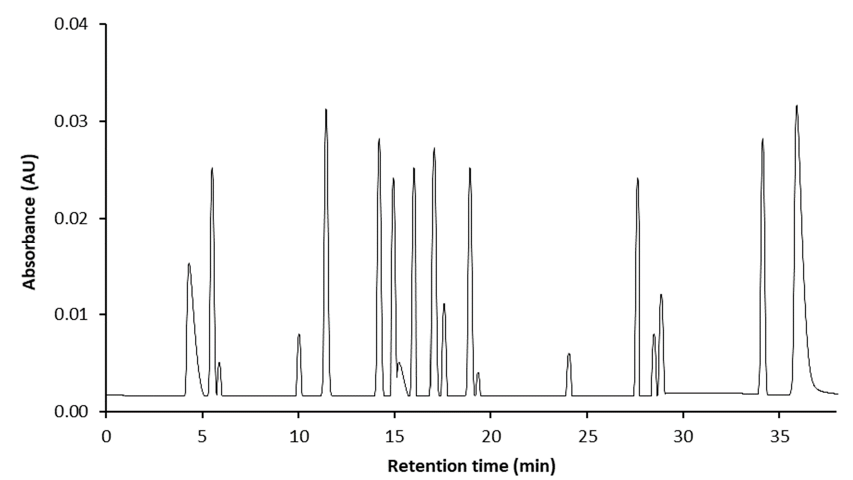
Figure 1. The ultra-high-performance liquid chromatography (UHPLC)–MS/MS chromatograms of the 18 phenolic compounds in standard mixture. 1, catechol; 2, chlorogenic acid; 3, protocatechuic acid; 4, epicatechin; 5, catechin; 6, vanillic acid; 7, caffeic acid; 8, syringic acid; 9, epigallocatechin gallate; 10, p -coumaric acid; 11, gallocatechin gallate; 12, epicatechin gallate; 13, rutin; 14, naringin; 15, ferulic acid; 16, sinapic acid; 17, quercetin; 18, kaempferol.